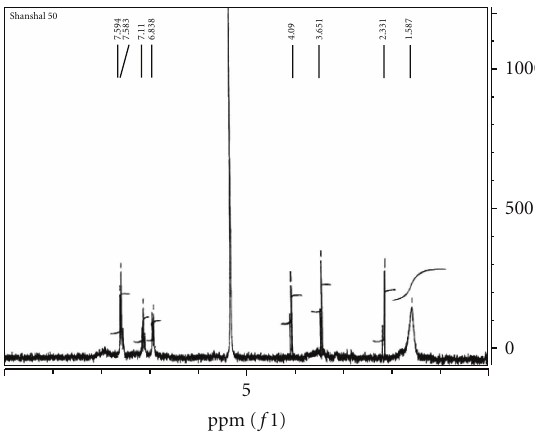
Figure 2: 1 HNMR Spectrum of L I H in DMSO.